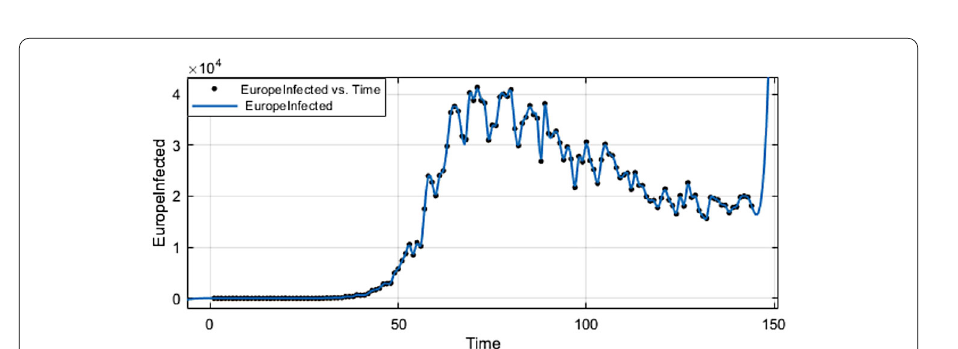
Figure 17 Fitting for the infected in Europe